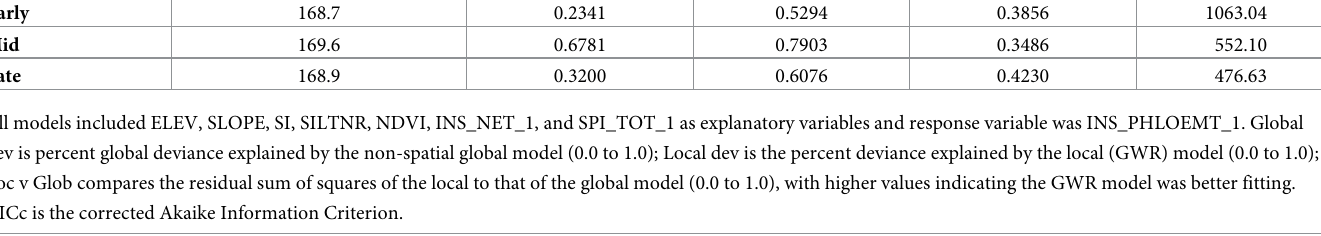
Table 11. Model diagnostics of geographically weighted regression (GWR) models for early, mid-, and late season (n = 162).